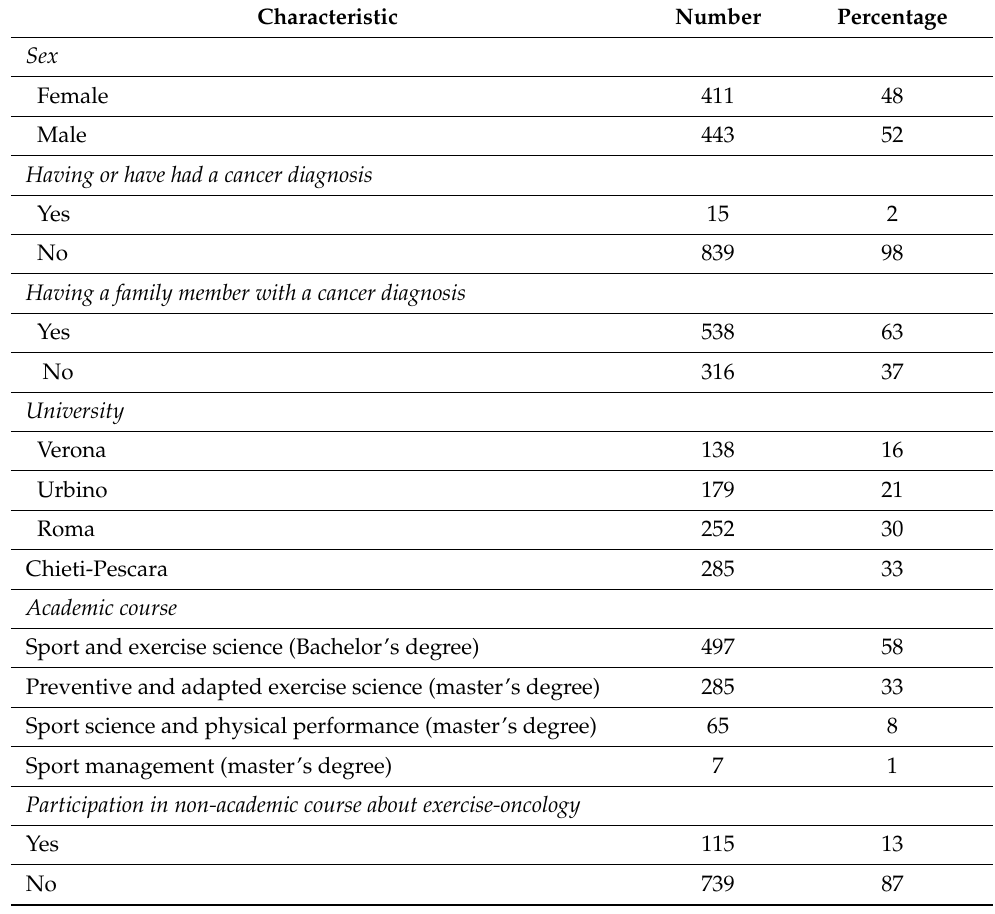
Table 1. Characteristics of the study’s participants.